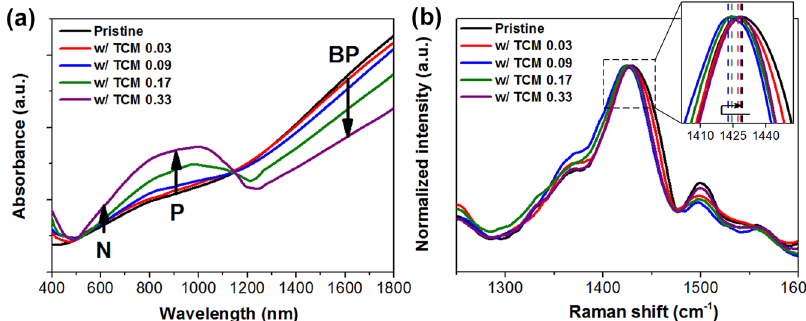
Fig. 4 Molecular conformation of PEDOT:PSS hybrid fi lm. a UV − vis – NIR spectra and b Raman spectra of spin-coated PEDOT:PSS/EMIM:TCM hybrid thin fi lms. Note that arrows marked with N, P and BP in ( a ) represent absorption features originating from neutral, polaronic and bipolaronic states, respectively. An inset consisting of details of the Raman peak shifts as a function of IL content is included in ( b